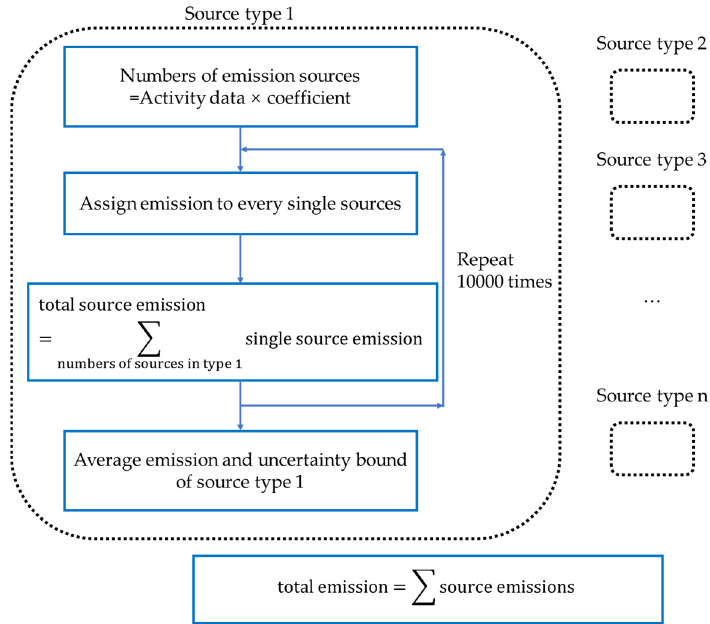
Figure 1. The model structure.